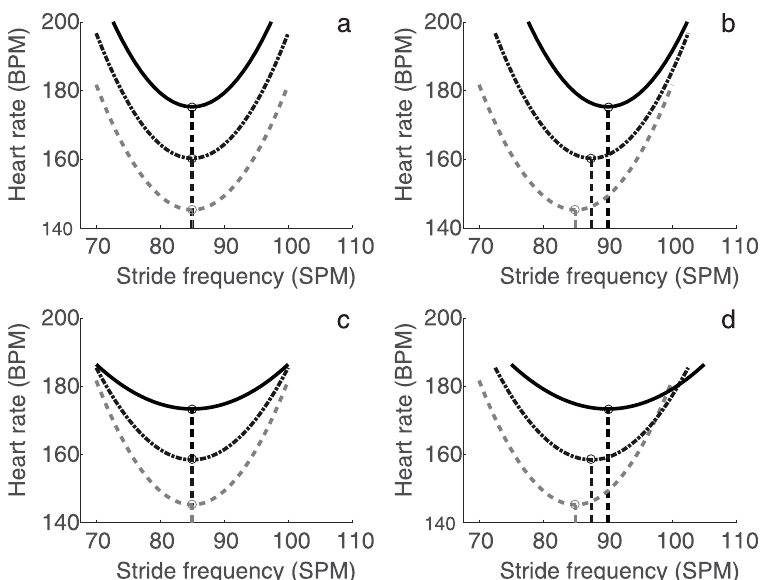
Fig 1. Hypothetical models to evaluate the effect of speed on the relation between stride frequency and heart rate. The dashedline (V90%), dash-dot (V100%)and solid line (V110%)respectivelyrepresent three increasing speed